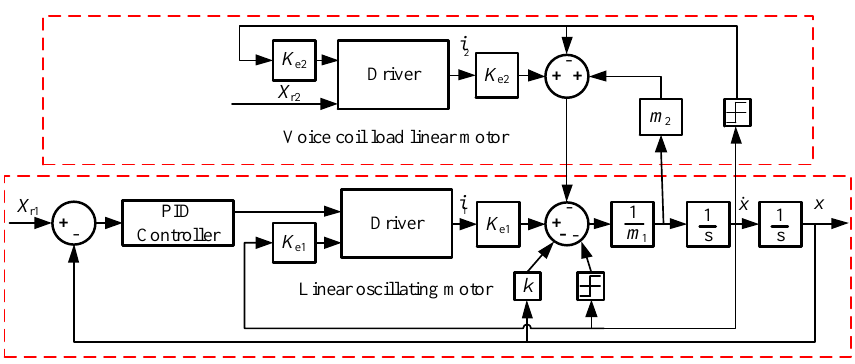
Figure 12. Block diagram of the linear oscillating load system (LOLS).